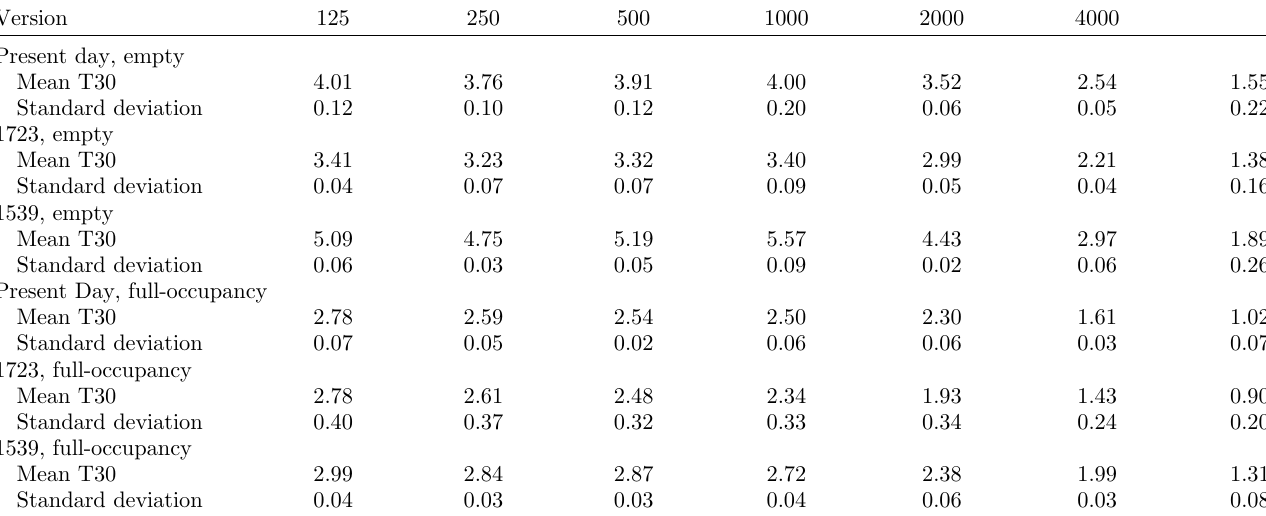
Table 7. Simulated spatially averaged T30 (s) from source A by octave band in all eras for the empty and full-occupancy Thomaskirche GA